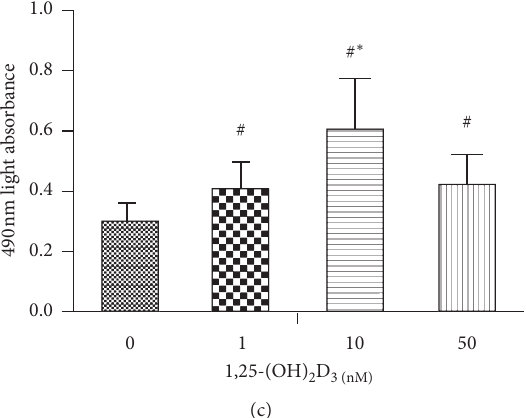
Figure 3: The effect of 1,25-(OH) 2 D 3 on the number, migration, and proliferation of EPCs in vitro . The number, migration, and pro- liferation of EPCs were significantly increased after culturing in different concentrations of 1,25-(OH) 2 D 3 (a)–(c). # P < 0 . 05 vs blank control (0nM 1,25-(OH) 2 D 3 ), ∗ P < 0 . 05 vs 1 nM 1,25-(OH) 2 D 3